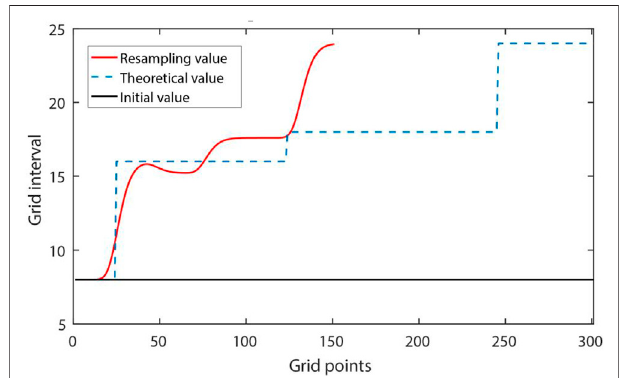
(17 ) FIGURE 5 | Comparison of vertical grid interval.